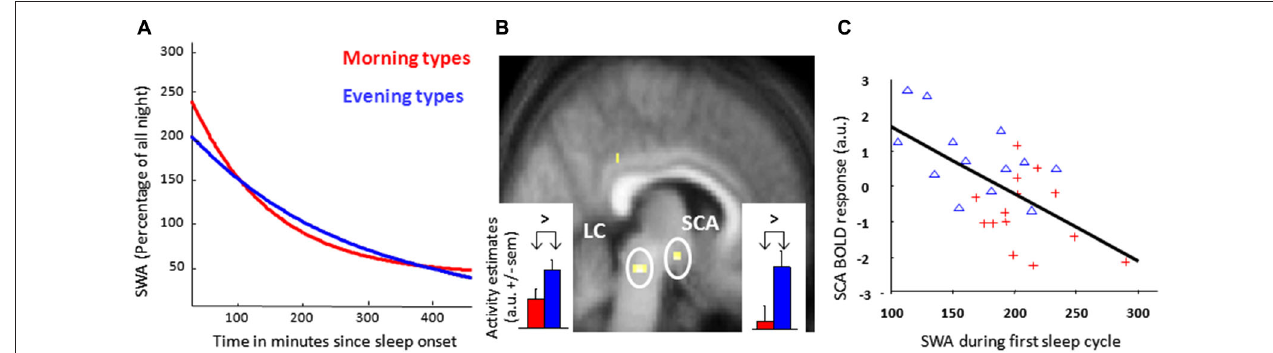
sustained attention during the performance of a Psychomotor Vigilance Task (PVT). Corresponding activity estimates (arbitrary units—a.u. + / − sem) are displayed for event indicators of fast reaction times. (C) Regression analysis of the relation between estimated blood oxygen level-dependent (BOLD) responses during optimal task performance in the SCA region and the amount of SWA during the first sleep cycle in the preceding night ( r = 0.54, p < 0.05, n = 27). Red crosses: morning types, blue triangles: evening types. [Copied with permission from Schmidt et al. (2009); Cajochen et al.